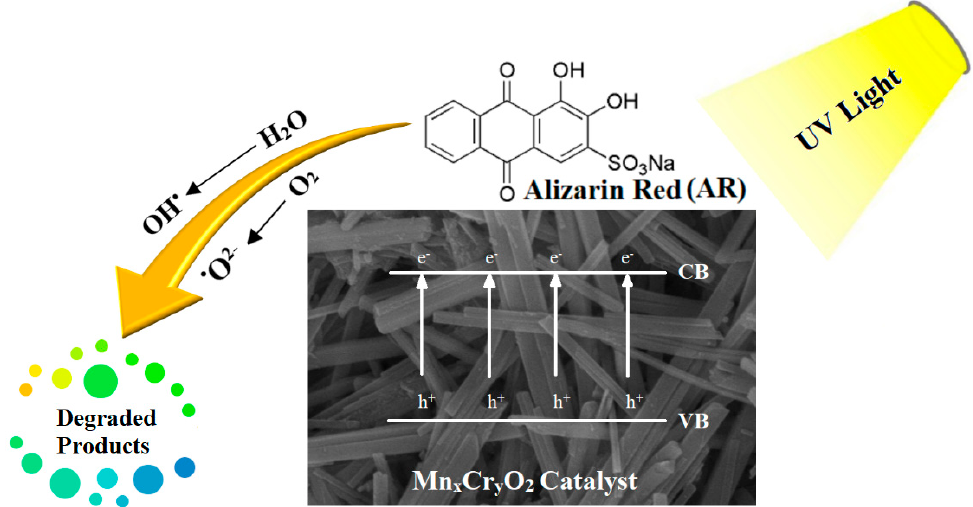
Figure 13. Proposed mechanism of AR dye degradation over surface of catalyst.